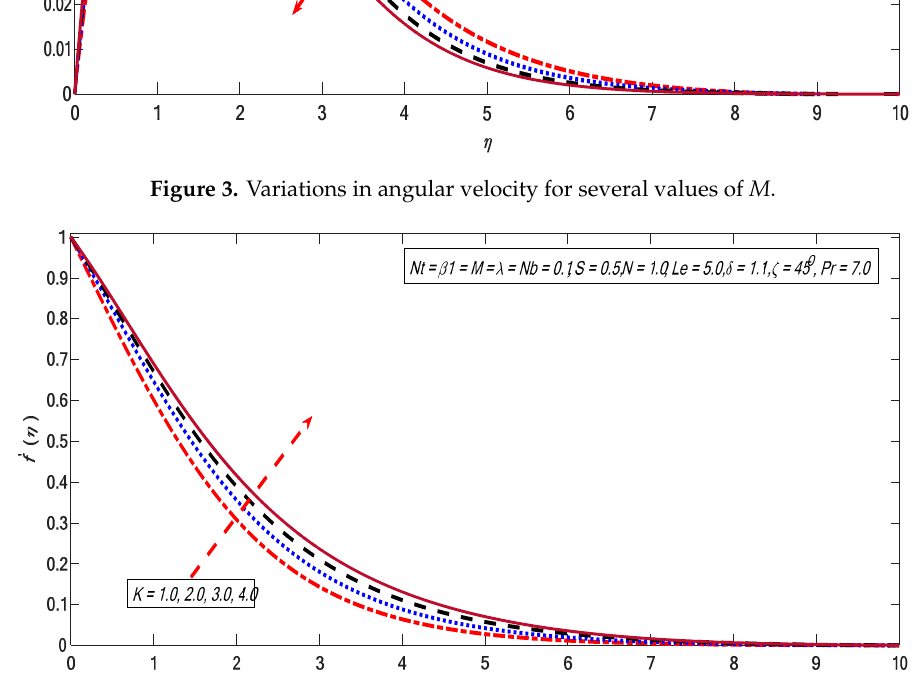
Figure 4. Variations in velocity profile for several values of 𝐾 .